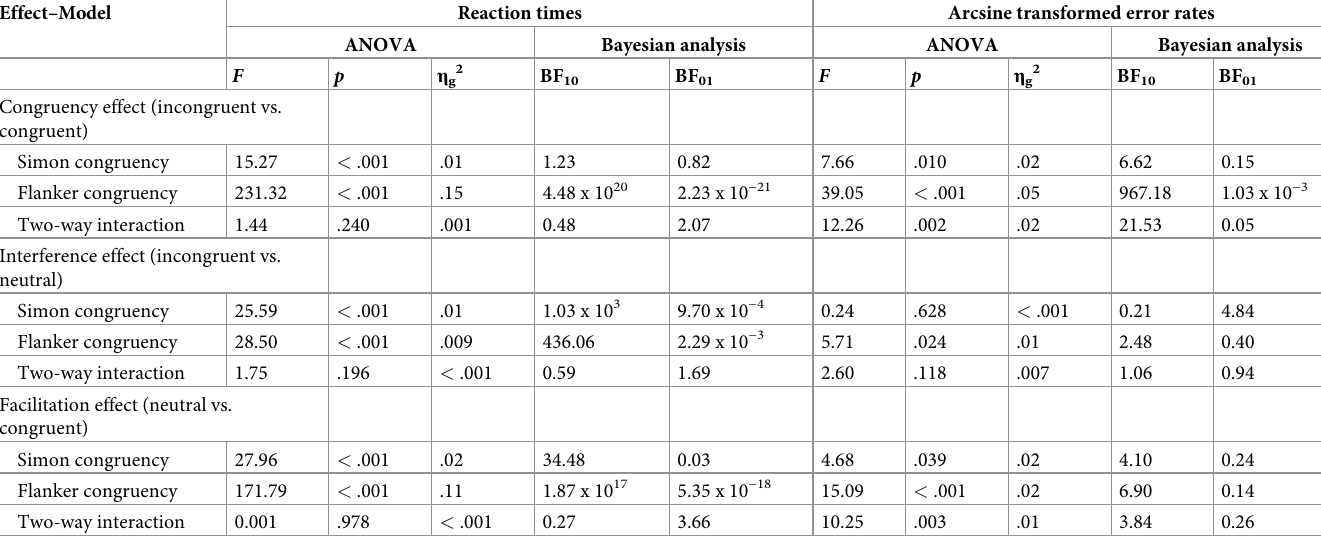
Table 3. Experiment 1b: Inferential statistical values for the two-way repeated-measures analysis of variance (ANOVA) with the variables Simon congruency and flanker congruency, and Bayes Factors (BF) from model comparisons.